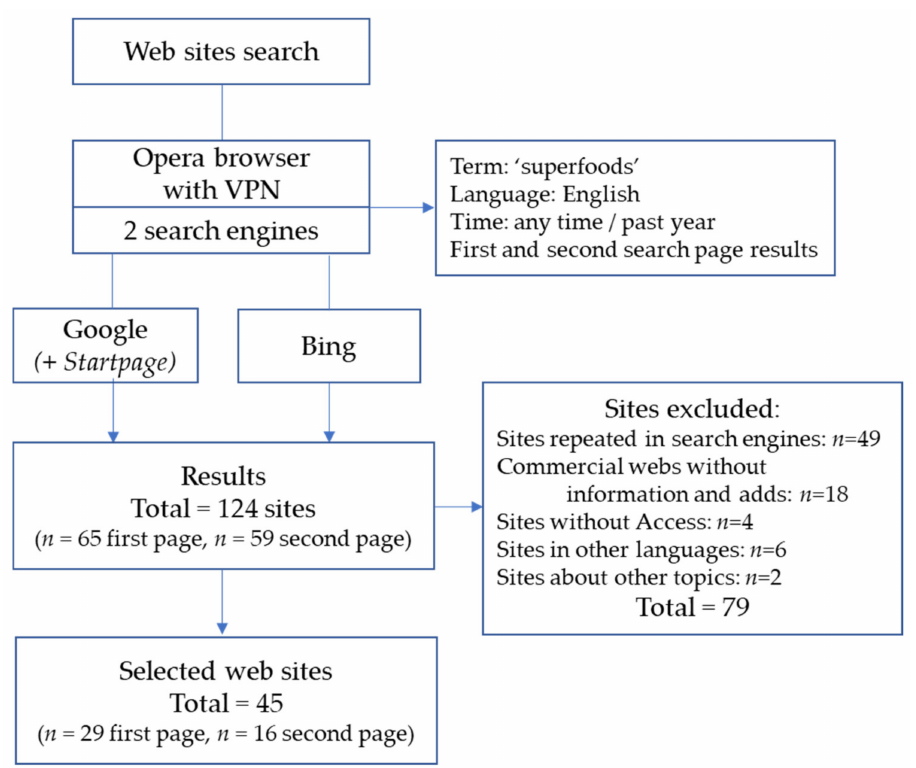
Figure 1. Flow diagram of the websites search and selection process. VPN: virtual private network.